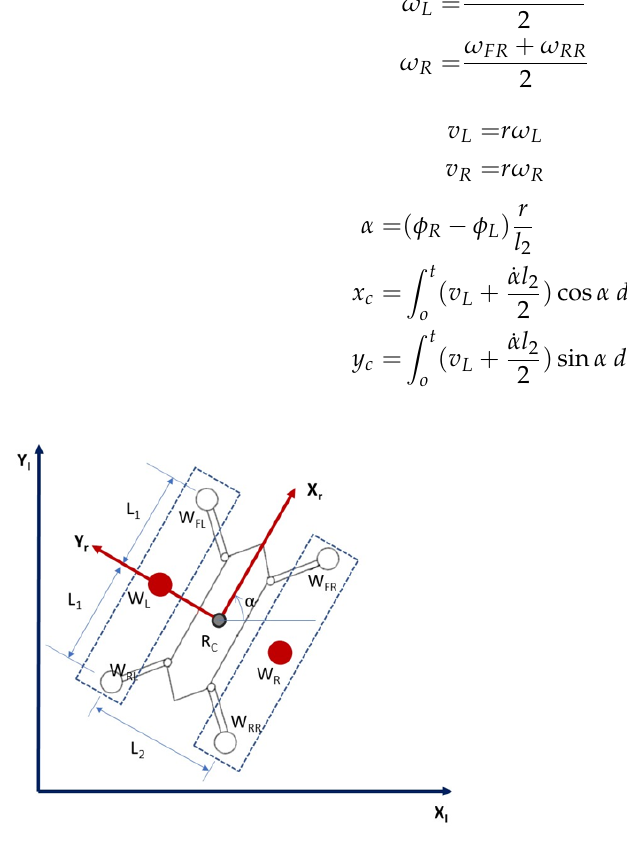
Figure 6. Schematic diagram of the wheel layout of the